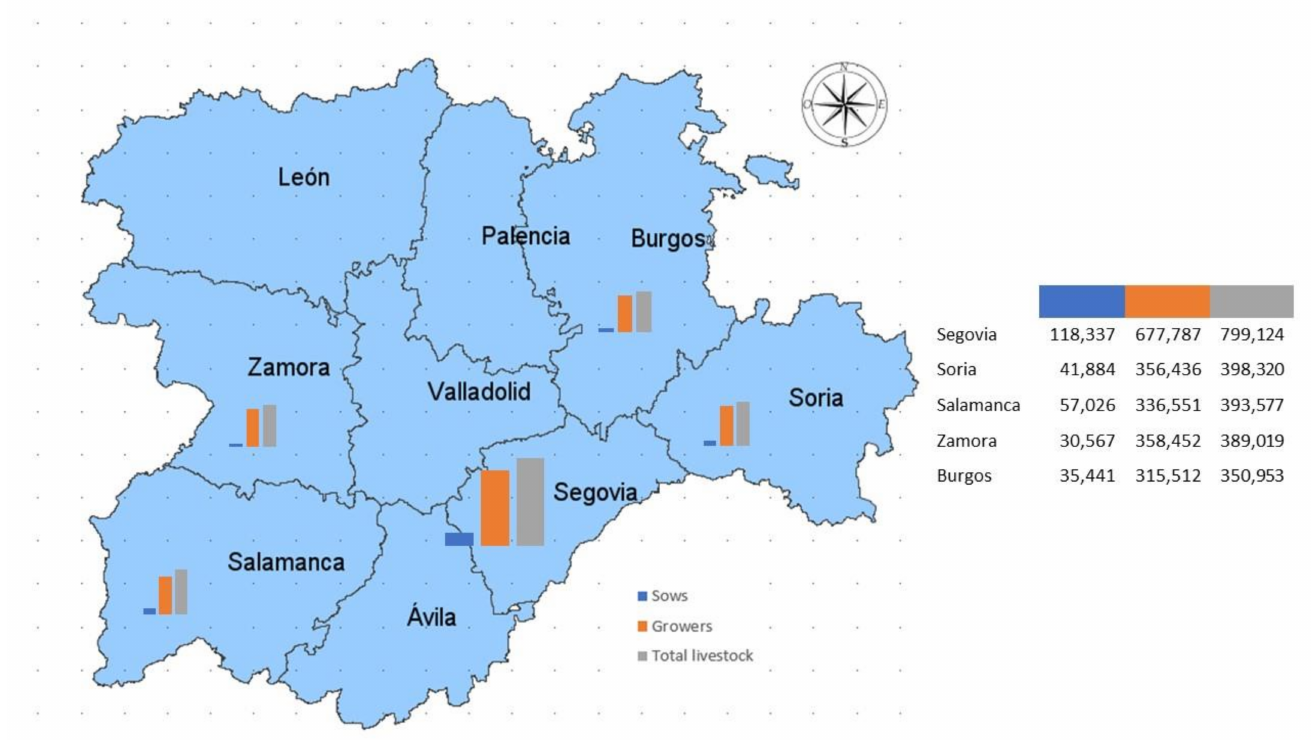
Figure 1. Porcine livestock in the five regions